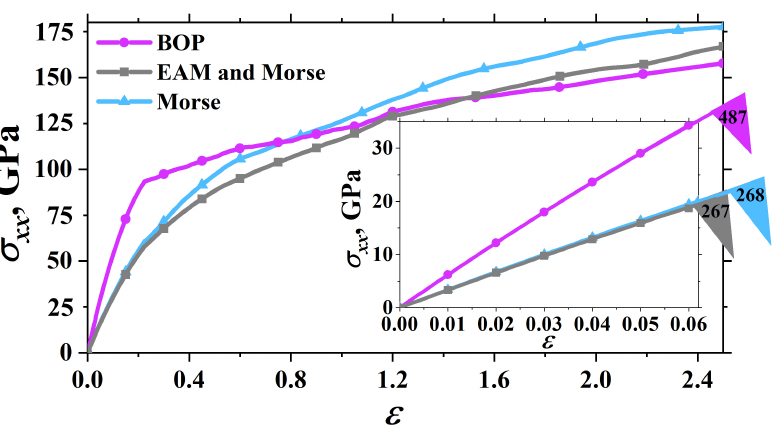
Figure 3. Stress-strain curves for composites under tension. The insertion shows the elastic regime and elastic